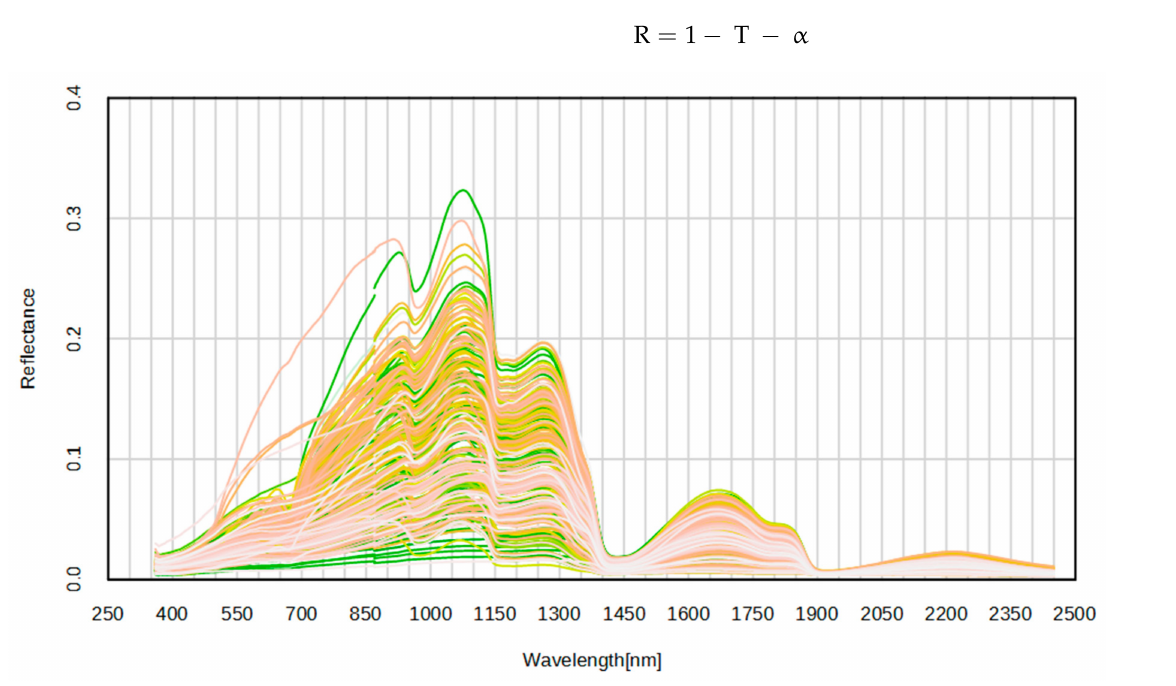
Figure 1. Typical VIS-NIR reflectance spectra for liquid organic manures (pig, cattle, digestate) from a study conducted in north Germany (detected with UV-VIS-NIR fibered ArcOptix spectrometer, ArcOptix, Neuchatel,